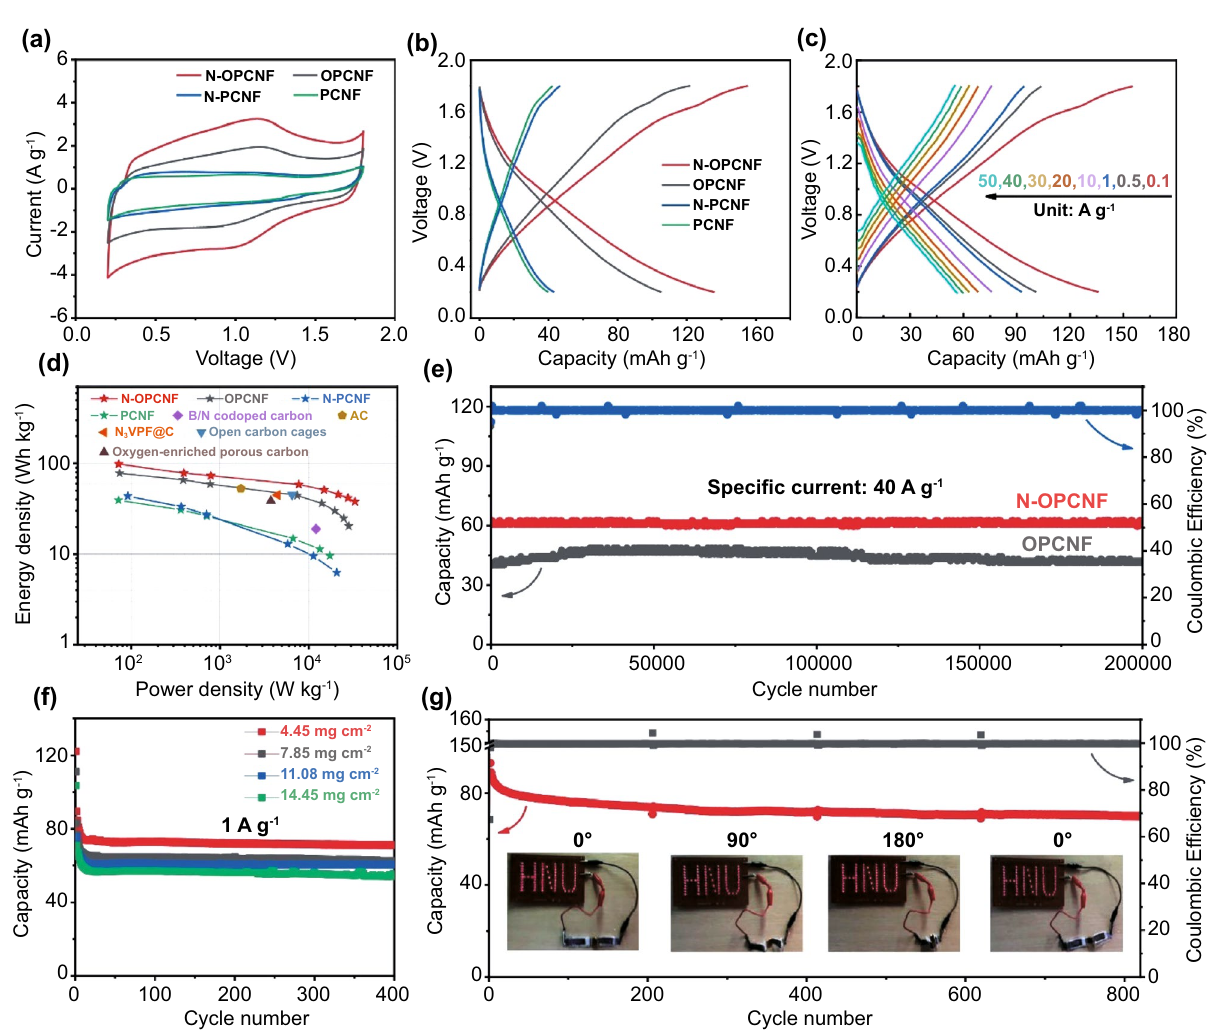
Fig. 2 a CV curves of PCNF, N-PCNF, OPCNF and N-OPCNF at a scan rate of 5 mV s −1 b GCD profiles of PCNF, N-PCNF, OPCNF and N-OPCNF at 0.1 A g −1 c GCD profiles of N-OPCNF at different current densities. d Ragone plots of N-OPCNF based ZIHCs compared with previously reported ZIHCs. e Long-term cyclic stability of N-OPCNF at 40 A g −1 . f Cycling performance of N-OPCNF under various mass loadings at 1 A g −1 . g Cycling performance of N-OPCNF pouch cell under different bending angles at 2 A g −1 (Inset: The N-OPCNF pouch cell lights up an “HNU” Logo in the different bent